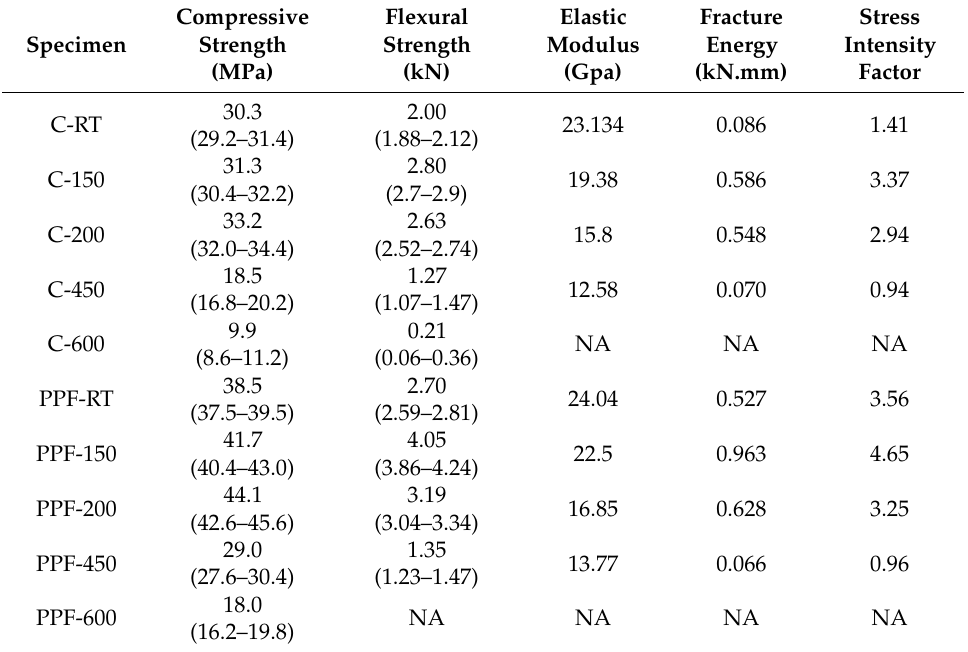
Table 3. Mechanical properties of plain and fiber-reinforced specimens exposed to different temperatures.